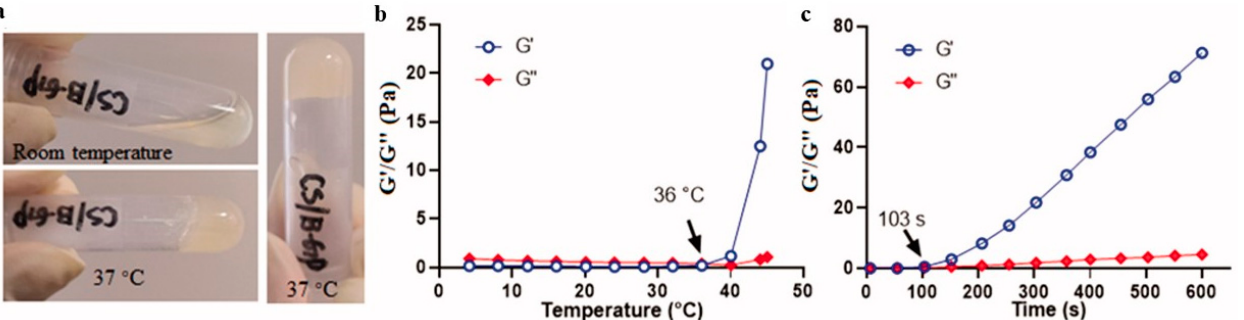
Figure 5. Formation of thermosensitive hydrogels ( a ) The representative images of thermosensitive hydrogels; ( b ) The temperature-dependent changes in the modulus of the hydrogel; ( c ) The time-dependent changes in the modulus of the hydrogel at 37 °C. (Reprinted with permission from Ref. [148]. 2020, Taylor & Francis).